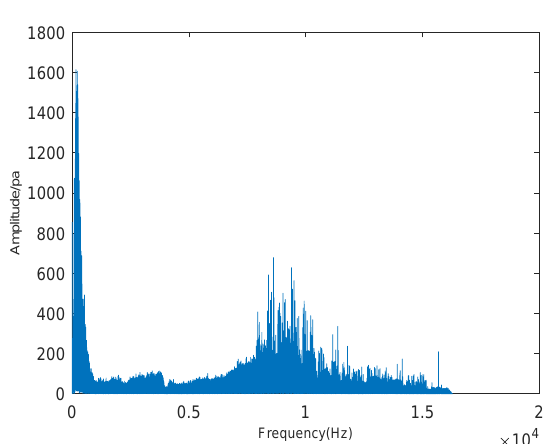
Figure 18. Frequency-domain sound